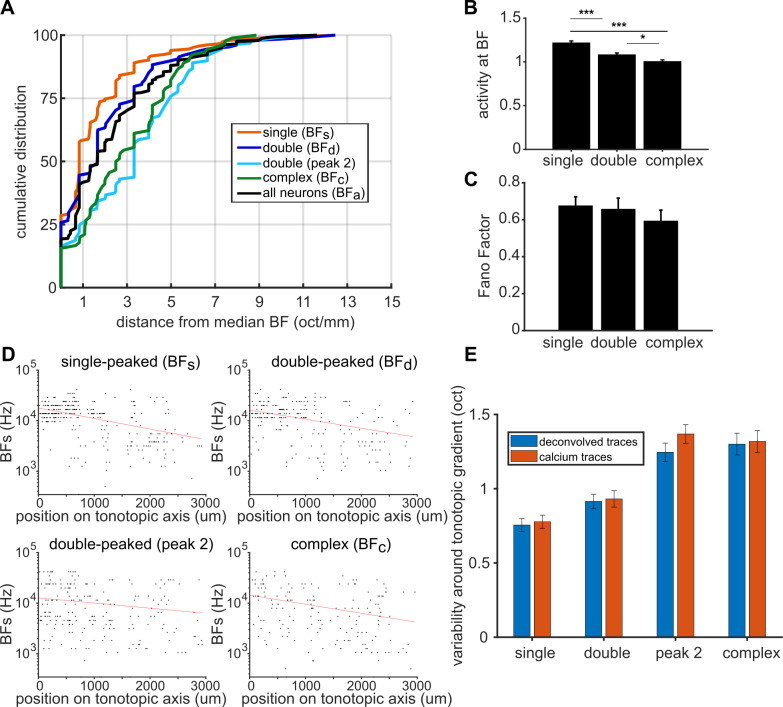
Comparison between deconvolved and non-deconvolved traces.(A) Cumulative probability plots of the difference (in octaves) between each neuron’s BF and the median BF of all neurons in the same FRA class and imaging field. Distributions for different FRA classes are plotted separately: single-peaked BFs; double-peaked BFd; double-peaked peak 2; complex BFc; and the BFa of all three FRAs together. (B) Magnitude of the trial-averaged response at BF, calculated from non-deconvolved fluorescence traces. Responses were averaged across all neurons in each FRA class, pooled across imaging fields and ferrets (mean ± SEM). Significant results of t-tests are shown above the bars: * p < 0.05, *** p < 0.001. (C) Fano Factor values calculated at BF (mean ± SEM) for single-peaked, double-peaked, and complex neurons in non-deconvolved fluorescence traces. T-tests show no significant differences between groups (p > 0.05). (D) BFs , BFd, peak 2, and BFc of each neuron are plotted against the neuron’s position along the tonotopic axis on the template A1. Red lines show the best single-term exponential fits to the data. (E) Average octave distance of each BF from the fit (red curves in D and Figure 4C) for deconvolved traces (blue) and non-deconvolved fluorescence traces (red) (mean ± SEM). T-tests show no significant differences between results of the two methods for each FRA type (p > 0.05).